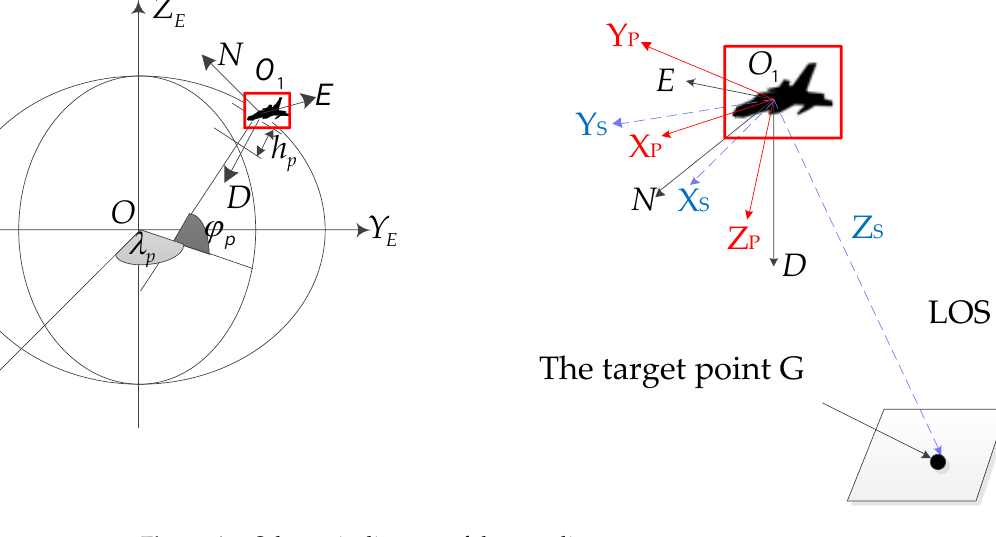
Figure A1. Schematic diagram of the coordinate systems. The geo-location of point G can be expressed as the longitude, latitude, and geodetic height (recorded λ G , φ G , and h G , respectively). The point G in the ECEF coordinate system can be expressed as Equation (A1) [16,35 – 38].